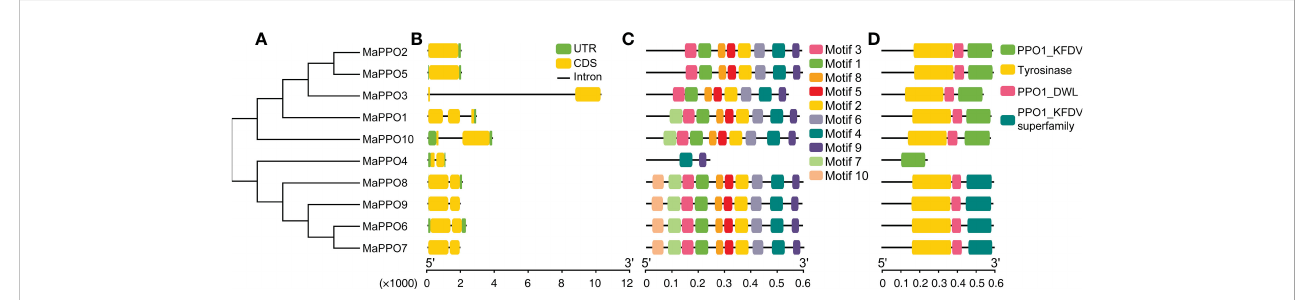
FIGURE 2 Phylogenetic, gene structure, motif, and conserved protein structure analyses of MaPPOs. (A) Phylogenetic relationship of MaPPOs . (B) Gene structure analysis using the genome sequences of MaPPO genes. Green boxes indicate UTRs; yellow boxes indicate exons; black lines indicate introns. (C) Motif presentation of the MaPPO members. (D) Conserved domain of MaPPOs.